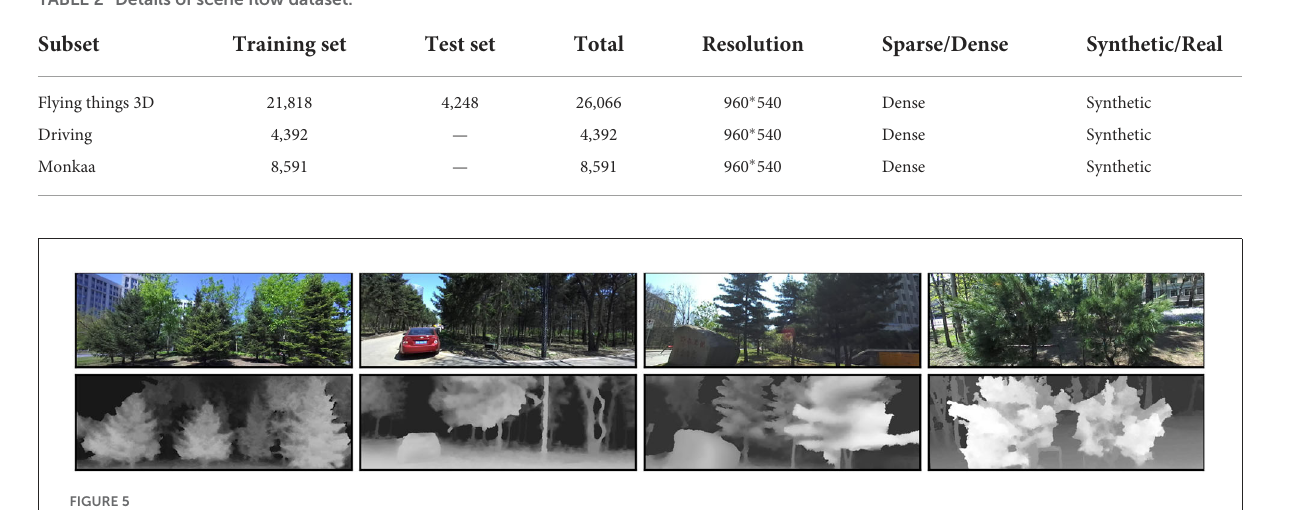
TABLE 2 Details of scene flow dataset.